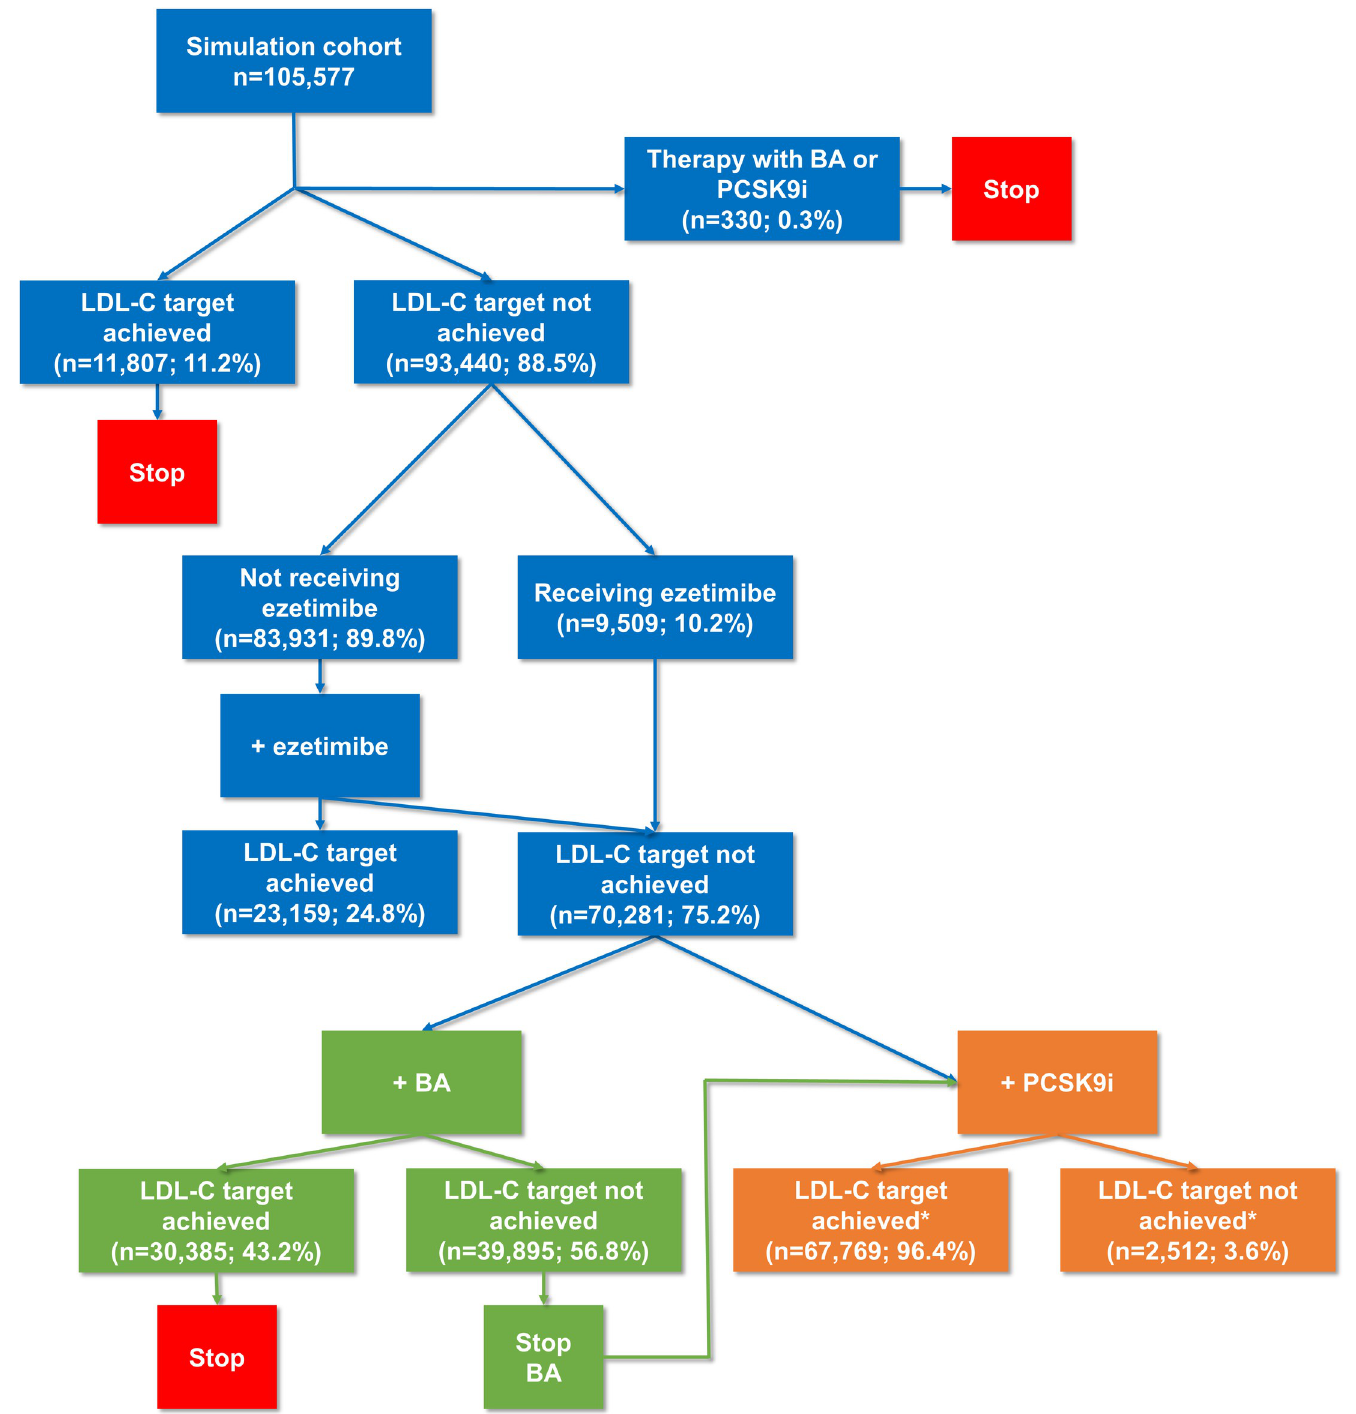
Fig 2. Treatment algorithm applied in the simulation study. Scenario (1) is shown in green, scenario (2) in orange. Percentages refer to the prior step of the algorithm. Slightly different patient numbers between consecutive steps of the simulation algorithm are the result of summarizing the counts of respective patients across the 10,000 simulations by the median. Notes: � Numbers of patients achieving the LDL-C goal are provided for scenario (2). The numbers slightly differed for scenario (1) with n = 67,853 (96.5%) of patients achieving the LDL-C target and n = 2,428 (3.5%) not. BA: Bempedoic acid, PCSK9i: PCSK9 inhibitor, LDL-C: Low- density lipoprotein